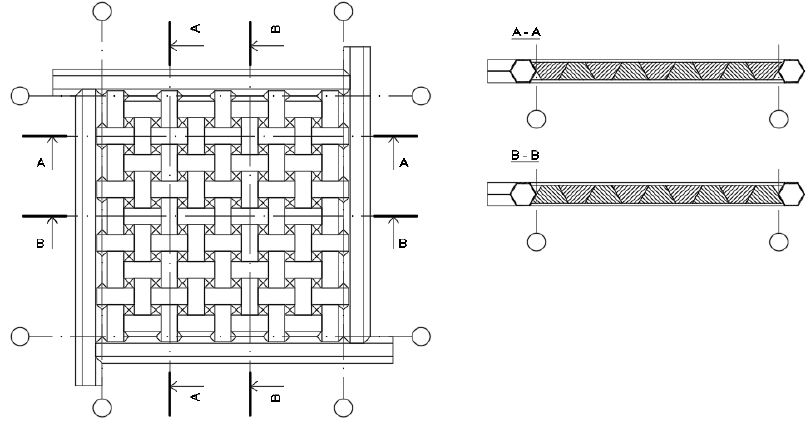
Figure 19. Co-operation between the flat vault and a grillage made of hexagonal pipes.